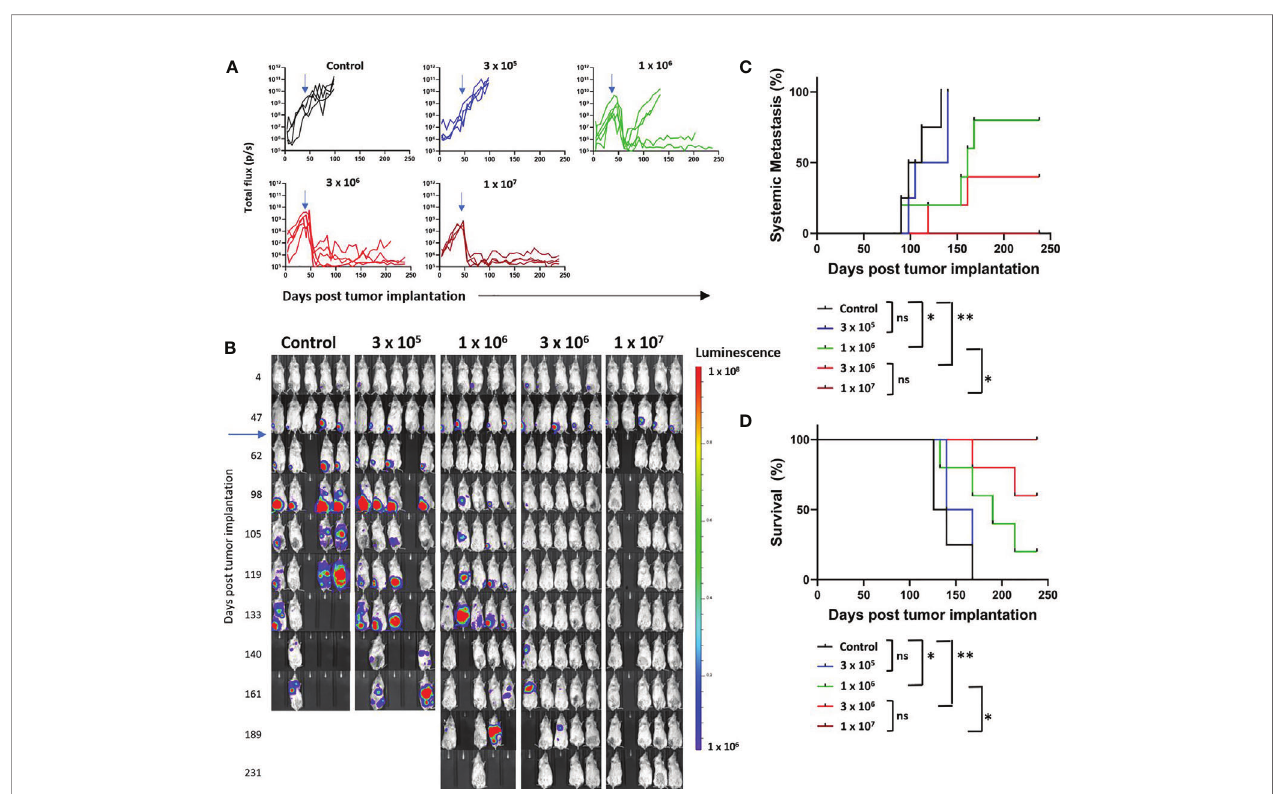
FIGURE 3 | Growth and metastasis of LM7 OS cells in orthotopic model. LM7 OS cells expressing fi re fl y luciferase were embedded in highly-viscous collagen and implanted into the tibia of NSG mice on Day 0. On day 48, CAR T cells were injected by tail vein at indicated doses (blue arrows). Mice were followed by serial bioluminescence imaging and underwent hindlimb amputation or sacri fi ce as described in the text. (A) Quanti fi ed growth of OS tumors after implantation (total fl ux (p/s) per ROI). (B) Serial imaging of implanted mice over time. (C) Cumulative incidence curve indicating development of systemic disease as determined by non-tibial bioluminescent signal appearance in two consecutive images. (D) Kaplan-Meier curve indicating overall survival of mice. N = 4-5 mice/group, 1 healthy T cell donor. Statistical analysis performed by log-rank testing. *p < 0.05; **p < 0.01. ns, not signi fi